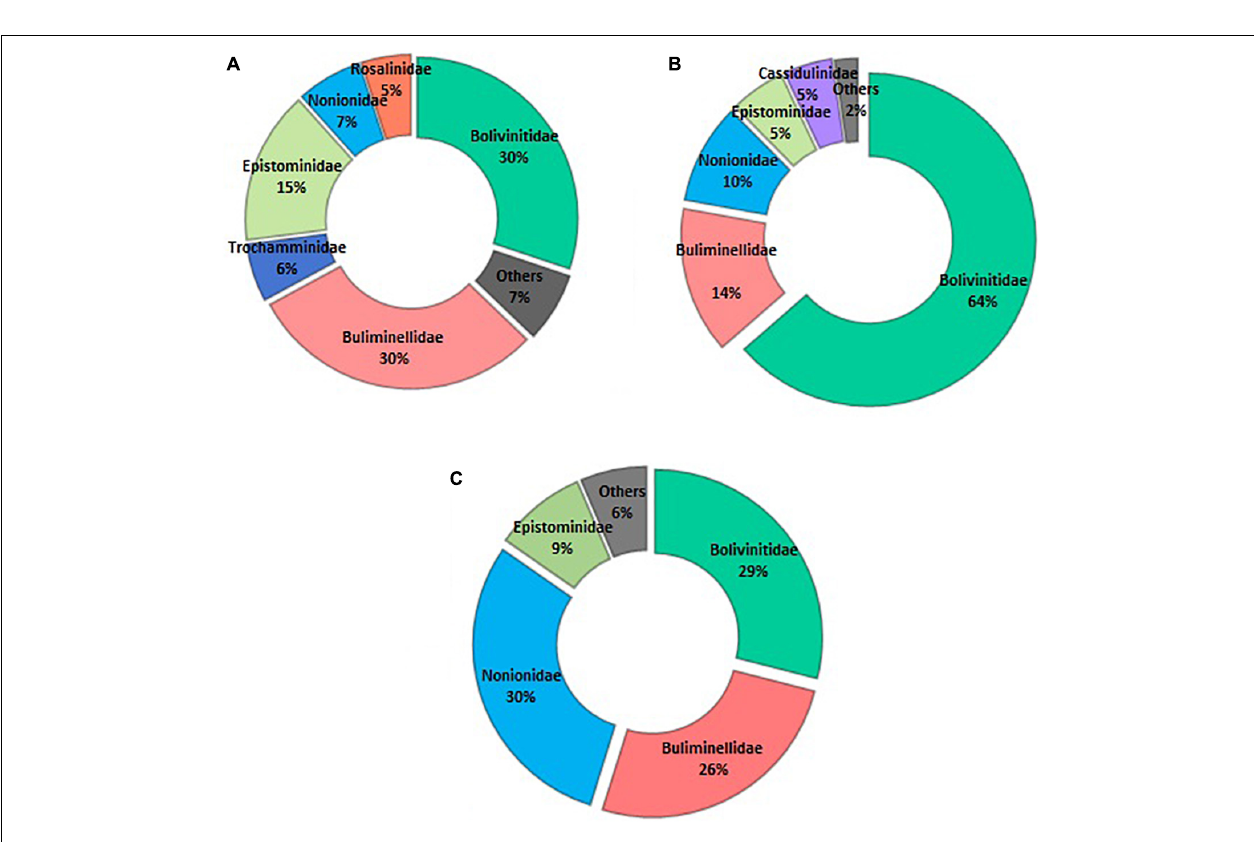
FIGURE 4 | Abundance (%) of the identified foraminifera families. (A) spatial distribution; (B) vertical distribution—core ZA; and (C) vertical distribution—core